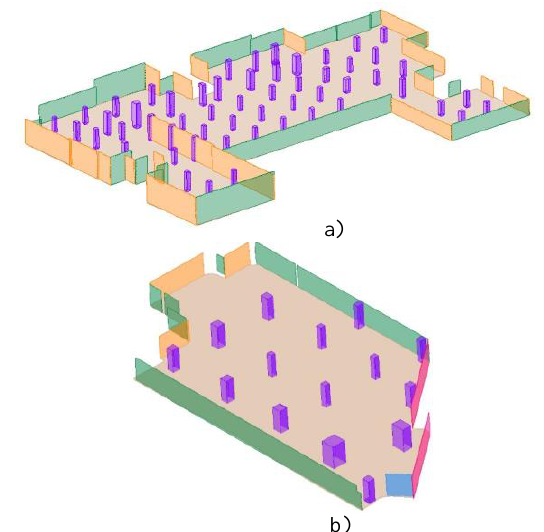
Figure 8 . Tetrahedrization for an automobile in the car park Figure 5 . Modelled surfaces for the car park (a) and the office point cloud. The left figure shows the raw coloured point cloud space (b). of a car. The middle figure shows that all the points of the car have been included in the same class (objects on floor). The right figure shows the volume of the car, identified as an individual